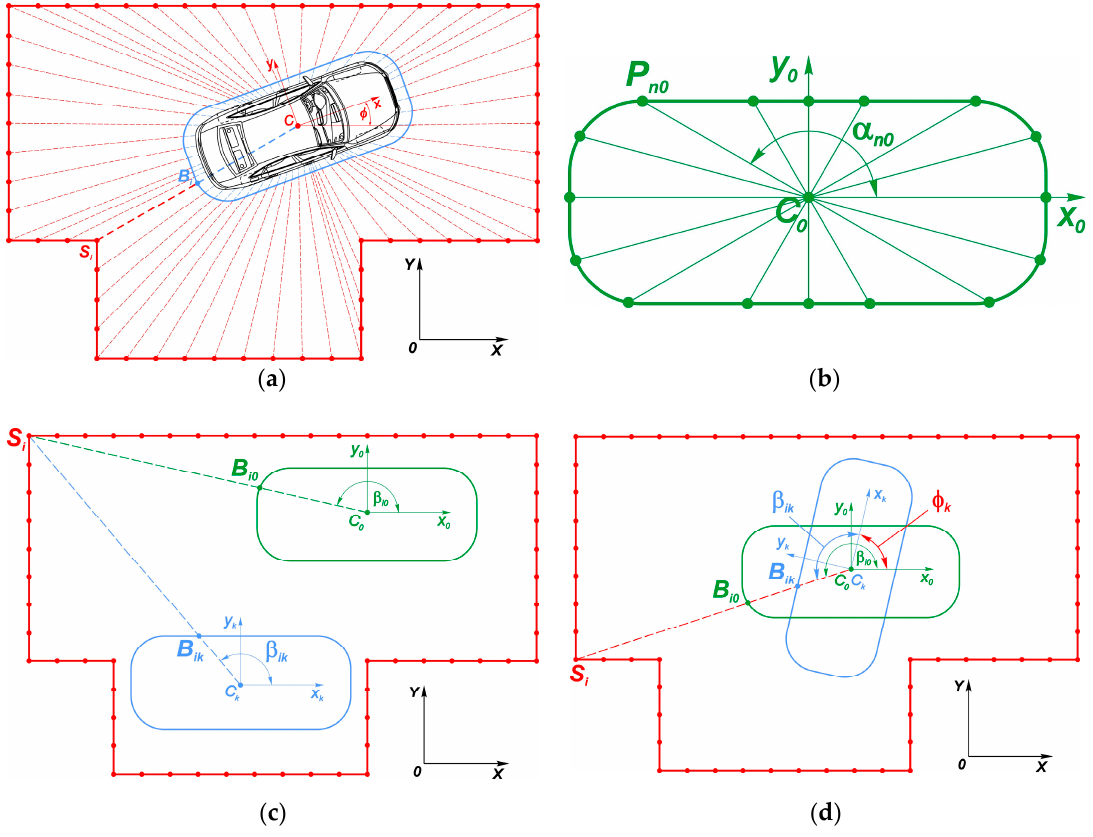
Figure 2. Determining mutual disposition between vehicle safe contour and parking area boundary: ( a ) Scheme of the general idea; ( b ) Vehicle's safe contour control points; ( c ) Control points due to vehicle translational motion; ( d ) Control points due to vehicle rotation.